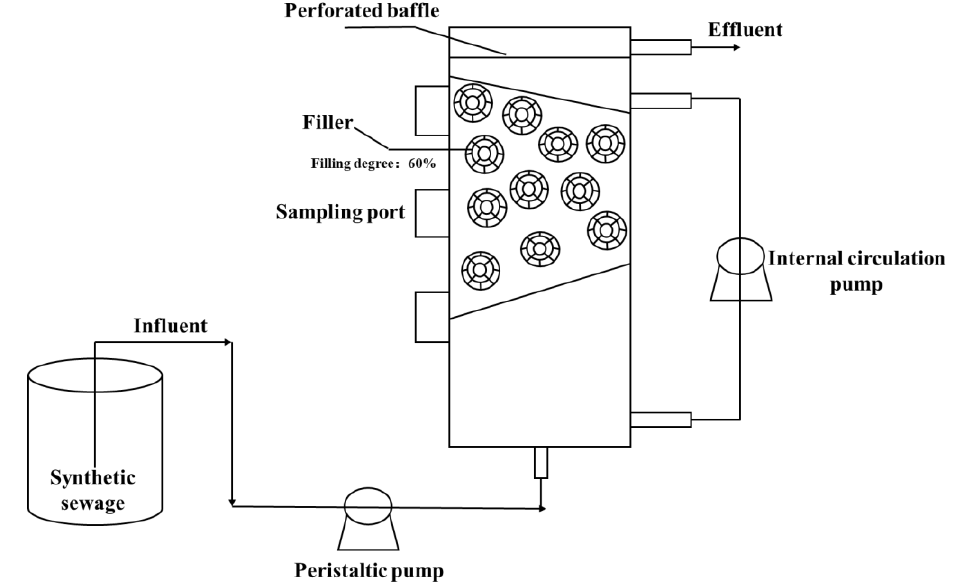
Figure 1. The schematic diagram of the MBBR.